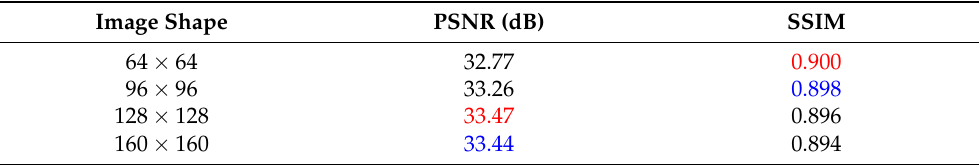
Table 3. Average PSNR and SSIM of Ref-MFFDN when dealing with images of different scales. The highest score is highlighted in red while the second-highest score is highlighted in